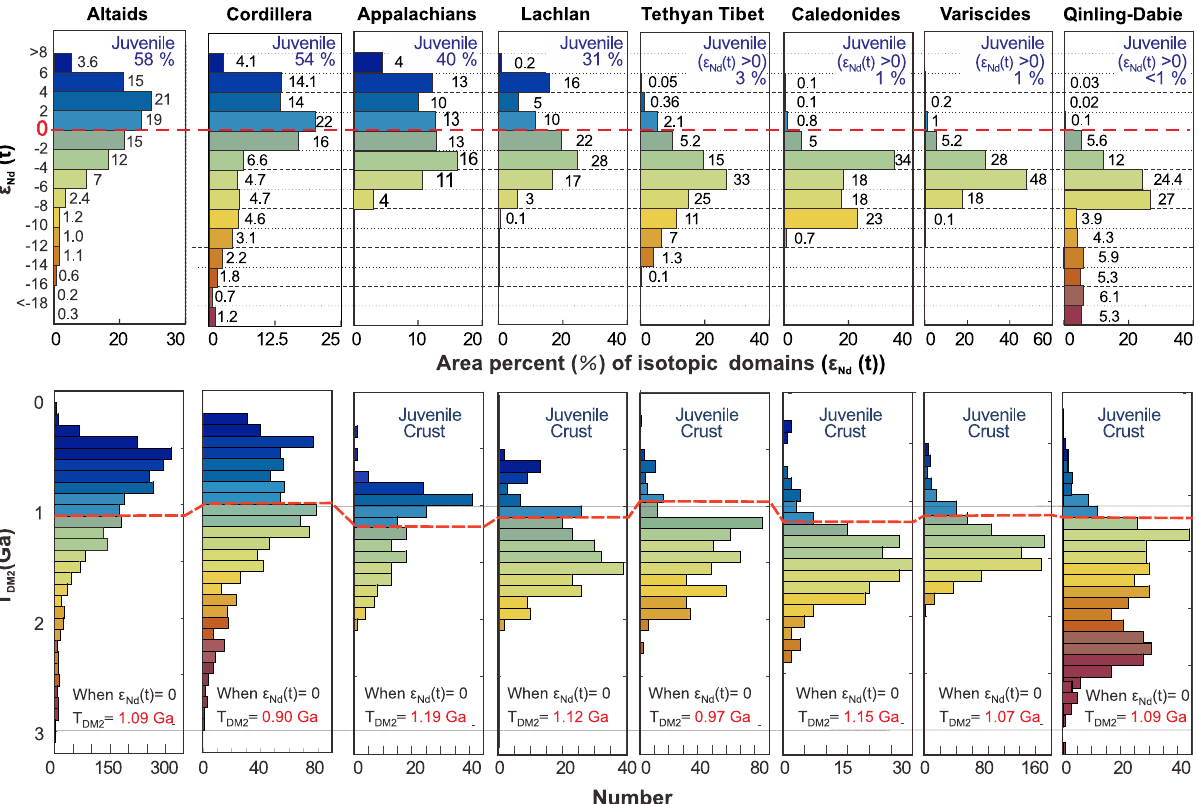
Fig. 3 Diagrams of ε Nd (t) value vs. area percent of isotopic domains (upper row), showing the total areal percent of the primitive province or juvenile crust ( ε Nd (t) > 0; blue area) for each orogen. The color scales are de fi ned by per 2 ε Nd(t) value interval, the same as those in Fig. 2. The lower row diagrams are histograms of T DM2 for each orogen. Blue areas denote primitive domains or juvenile crust younger than T DM2 corresponding to ε Nd (t) = 0; whereas the warmer colors re fl ect increasing amounts of ancient crust. The color scales are de fi ned by per 200 Myr T DM2 interval, the same as those in Supplementary Fig. 2. All the data are listed in Supplementary Data 9 and 10.